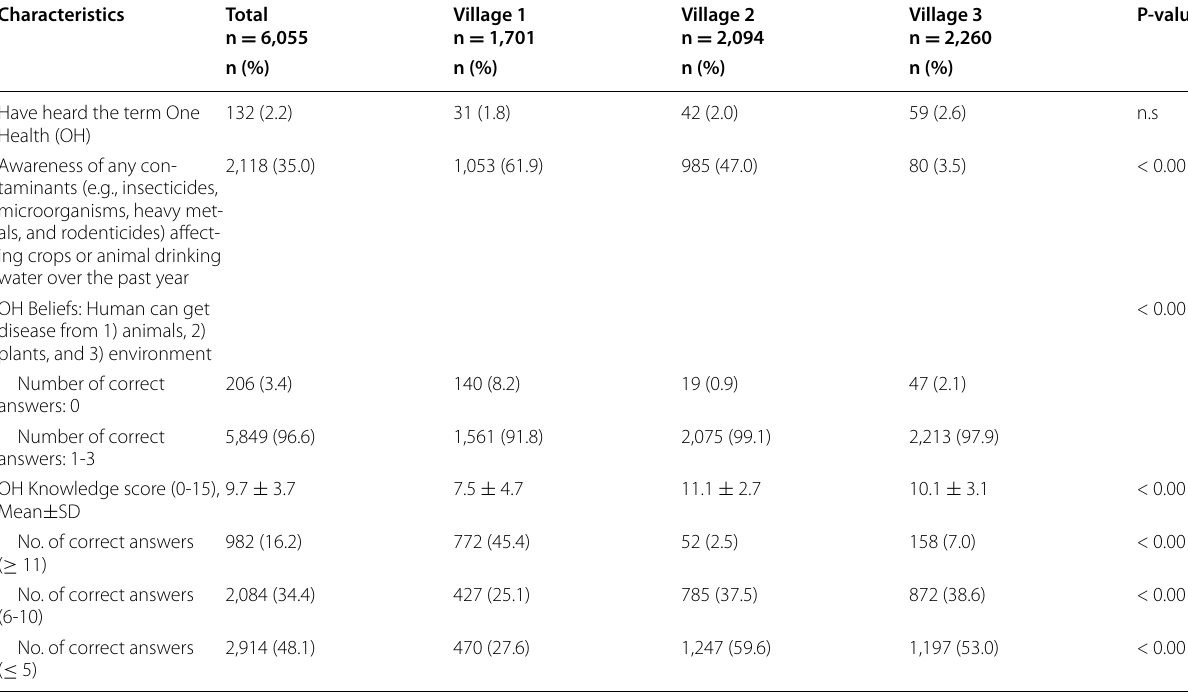
Note: SD standard deviation, n.s =